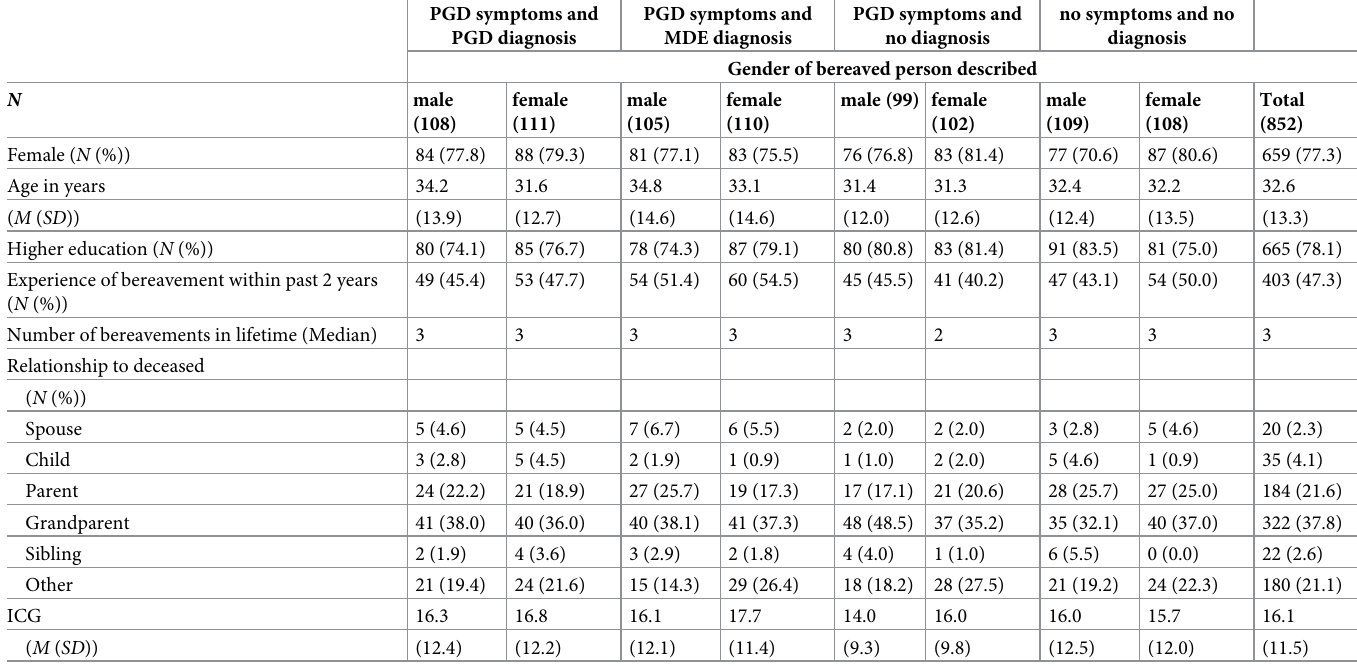
Table 2. Demographics per experimental group (mental health condition X gender of bereaved person described in the